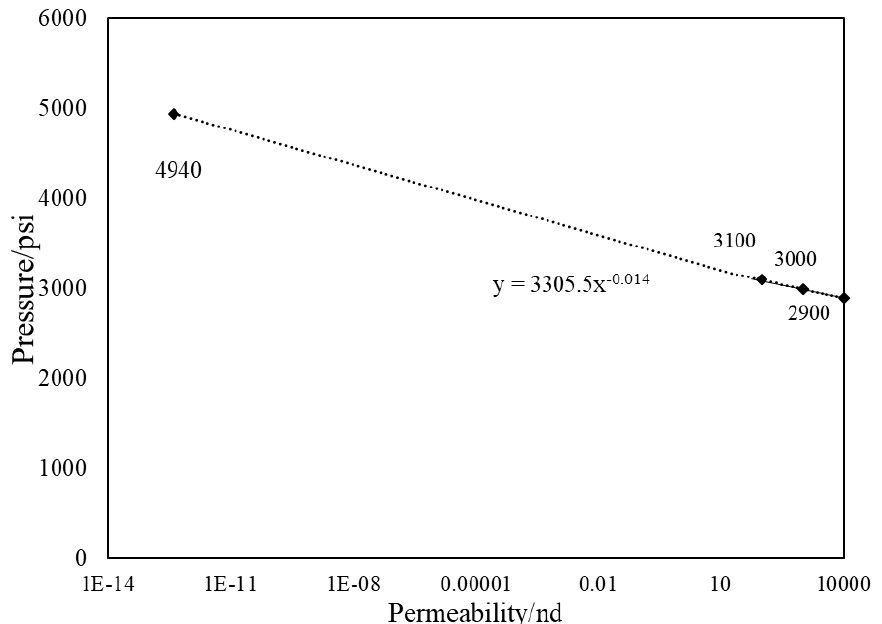
Figure 19. Recovery bending pressures of slim tube simulation vs. permeability with diffusion, Bakken.